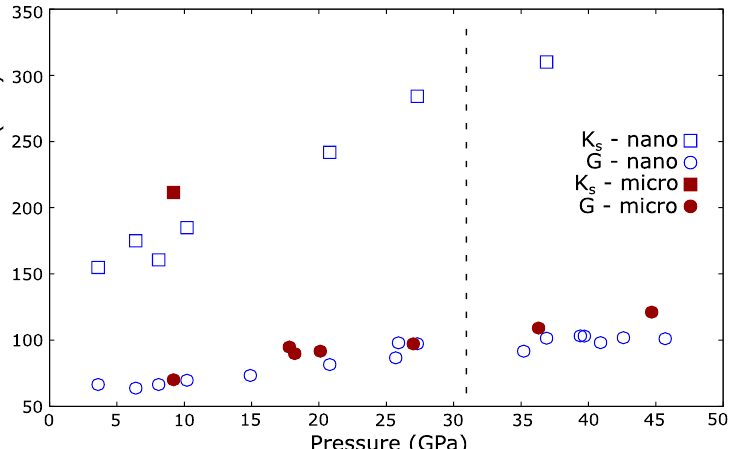
Figure 5. Adiabatic bulk moduli ( K s , squares) and shear moduli ( G , circles) of cerium dioxide nano- and micropowders (open and closed symbols respectively) as a function of pressure. Vertical dashed line indicates the nominal transition pressure from the Fm ¯3 m phase to Pnam